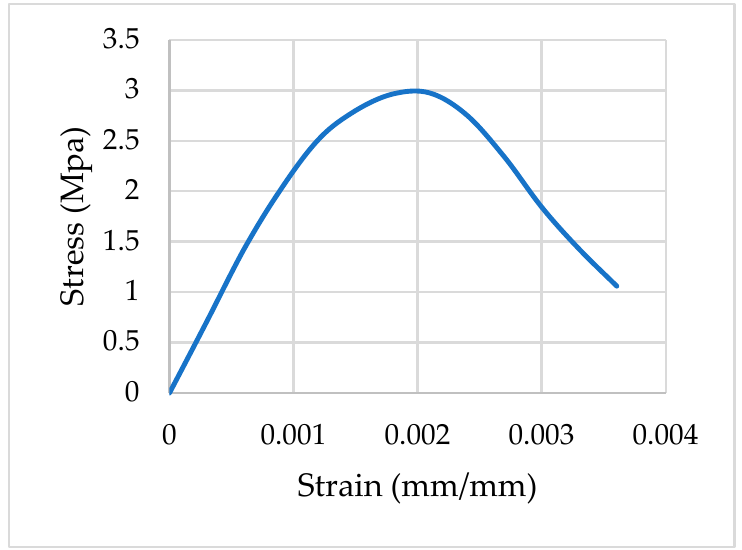
Figure 2. Stress–strain curve of AAC materials with a compressive strength of 3 MPa.